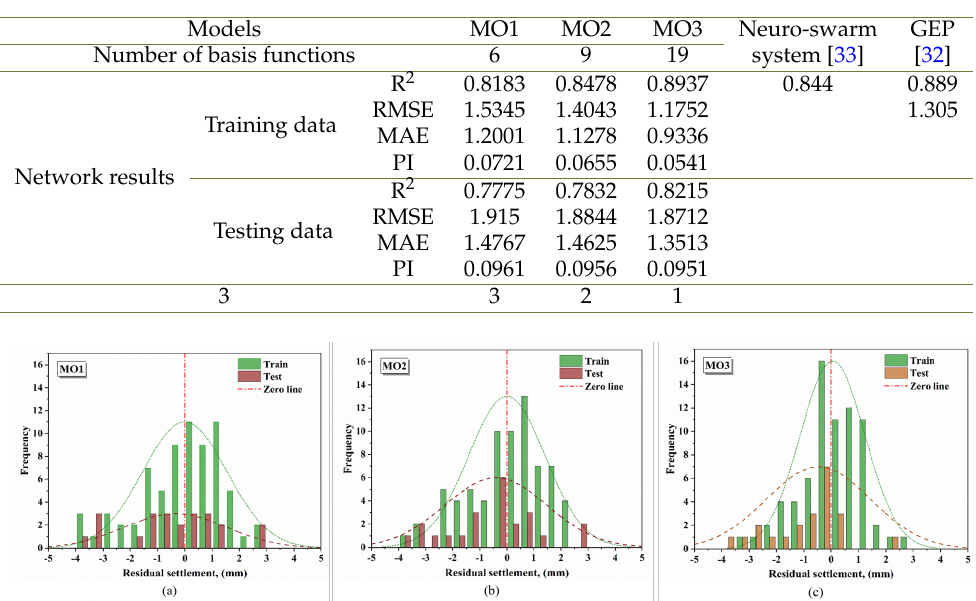
Table 3. The results of created models